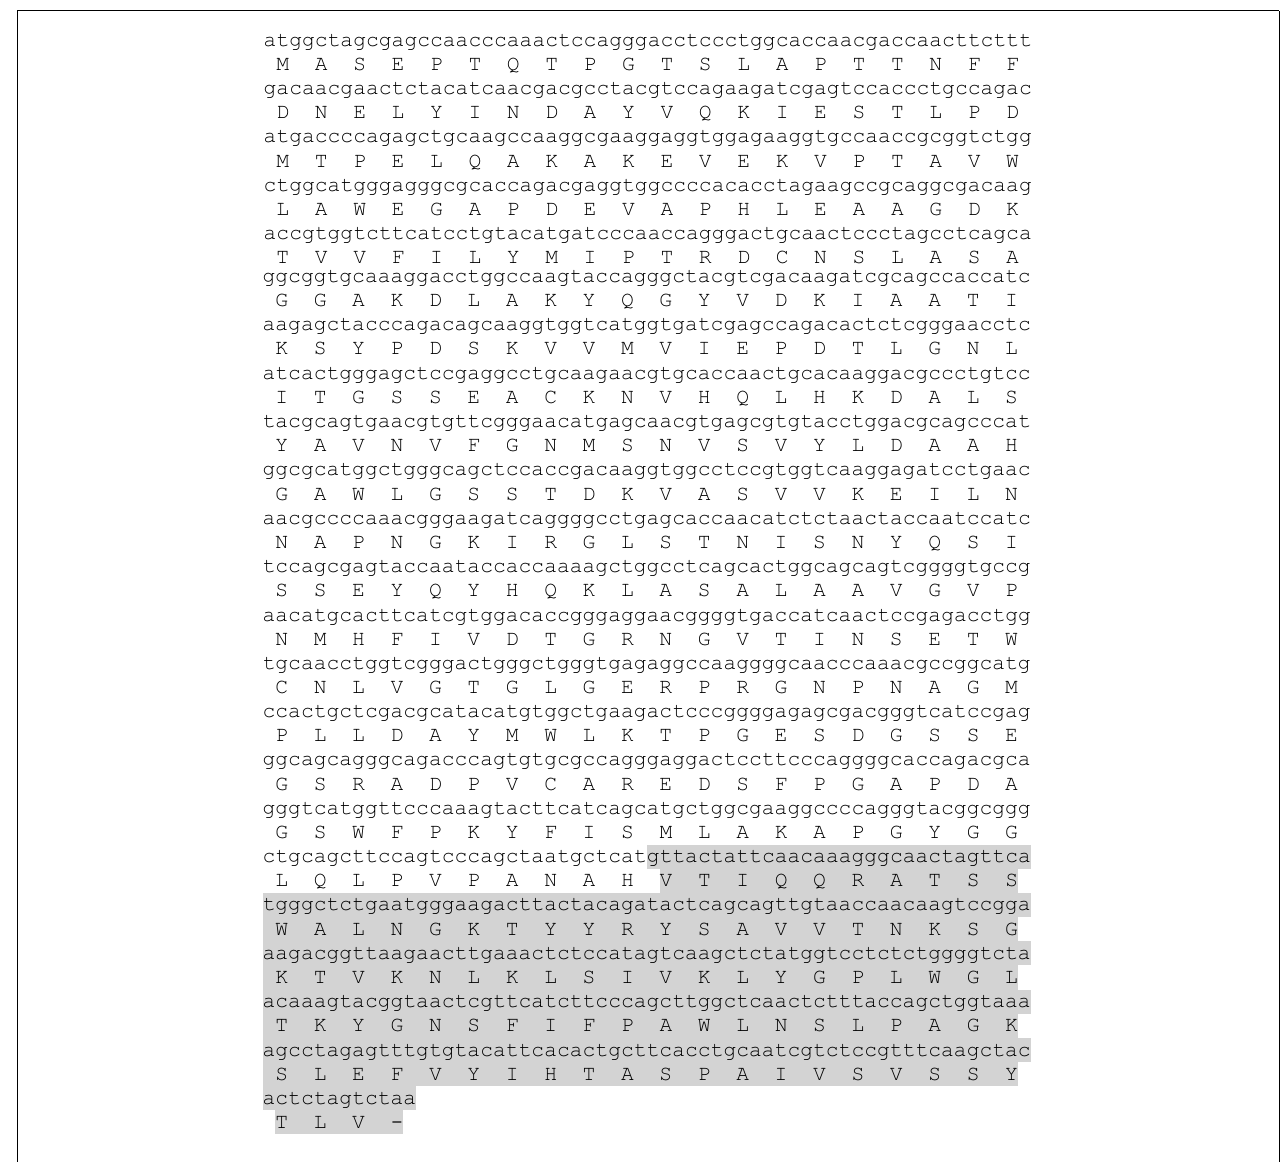
patriciarum and Piromyces sp. (Xue et al., 2003) and the carbohydrate binding module (CBM; shaded) is from the tomato CEL9 ( Solanum lycopersicum